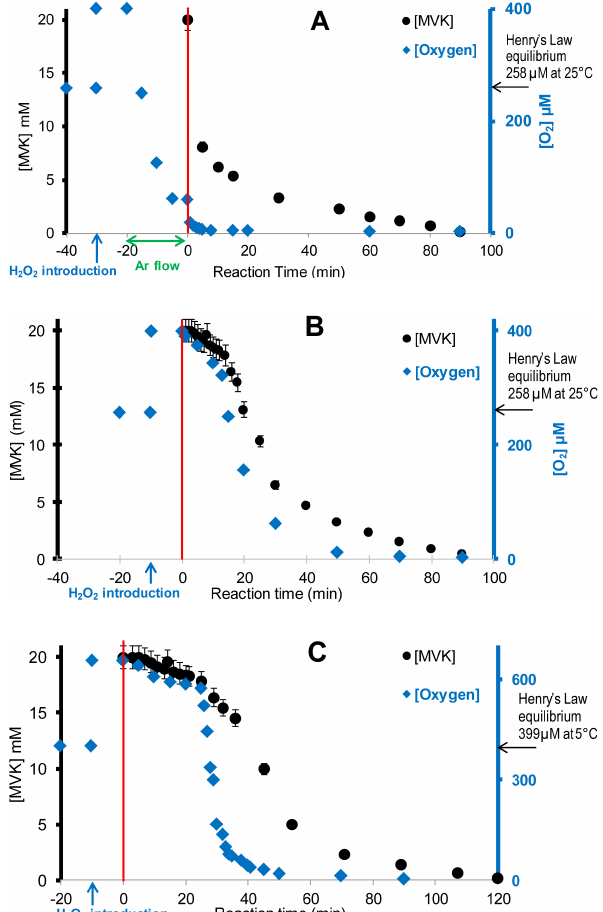
Fig. 9. Time profile of MVK and dissolved O 2 concentrations un- der different temperature and initial O 2 concentrations: A) experi- ment D (25 ◦ C, under low initial O 2 concentration: 60µM); (B) ex- periment A (25 ◦ C, under supersaturated initial O 2 concentration: 400µM); (C) experiment C (5 ◦ C, under supersaturated initial O 2 concentration: 400µM). Time 0 = MVK introduction (red